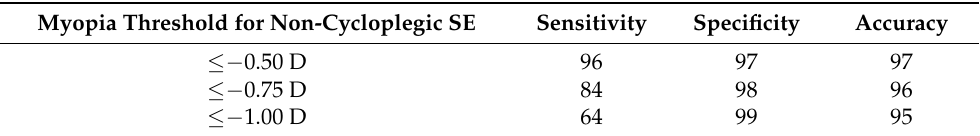
Table 2. Sensitivity specificity and accuracy for different myopia thresholds with non-cycloplegic open-field autorefraction against gold standard cycloplegic